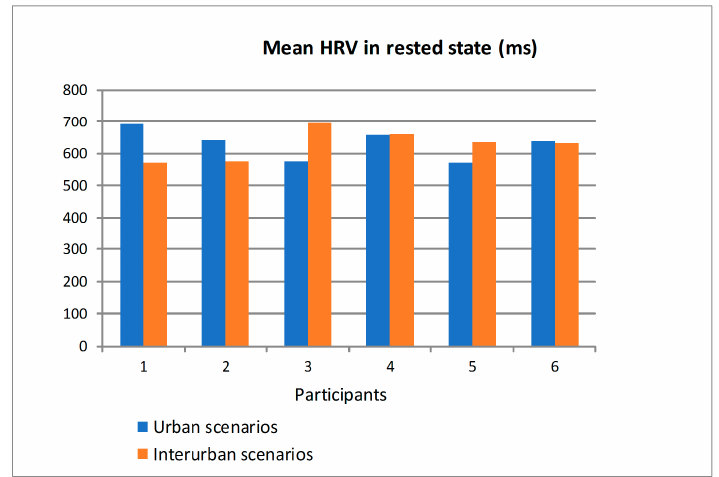
Figure 17. Mean HRV of the participants in rested state driving in urban and interurban scenarios.